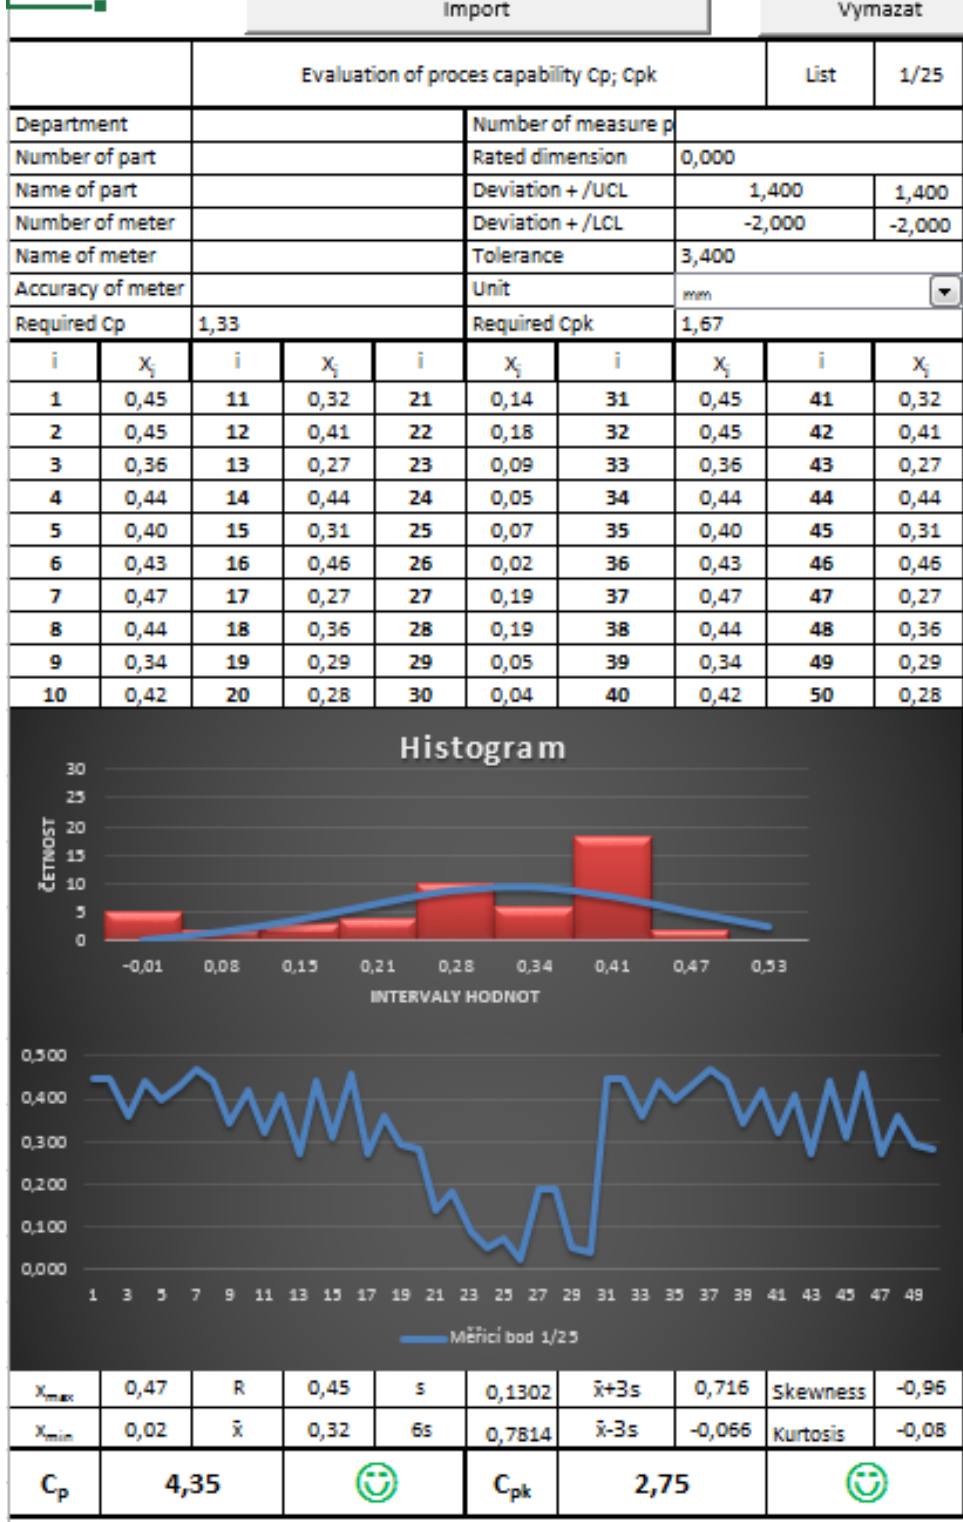
Figure 7: Visualization of the evaluation